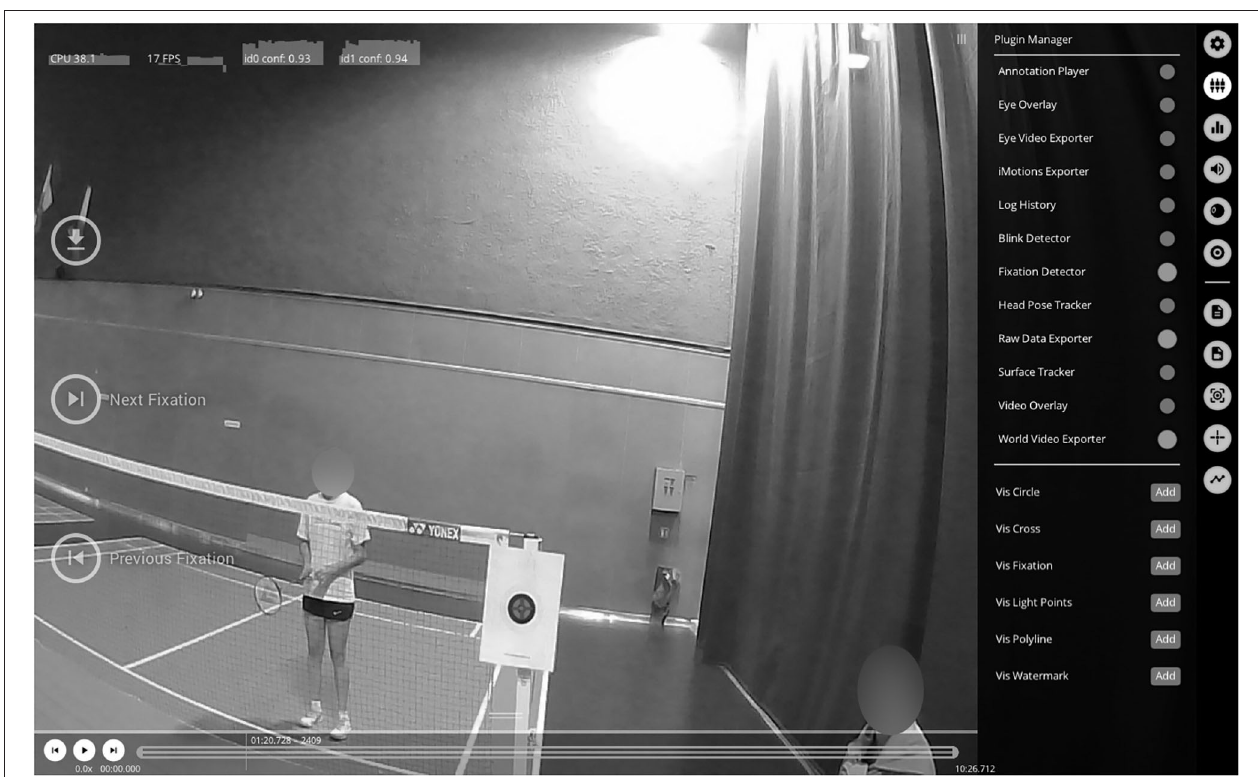
FIGURE 2 | Gaze point during single marker calibration obtained on Pupil Player software.